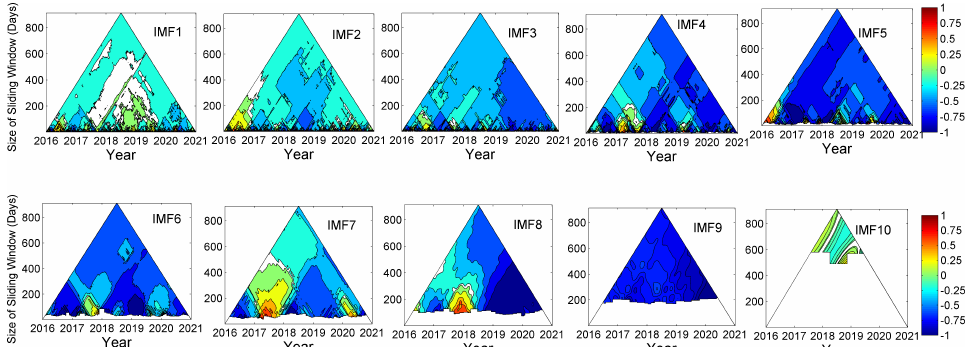
Figure 15. TDIC plots between wind speed ( U ) and wind direction ( WD ). The white spaces imply that correlation is not significant at the 5%